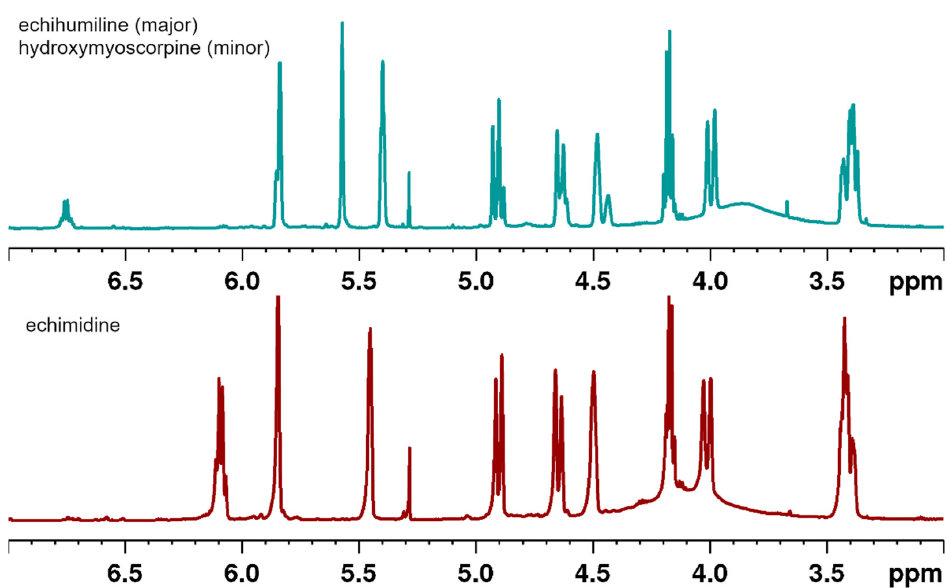
Figure 4. 1 H NMR spectra of echimidine and echihumiline-hydroxymyoscorpine mixture (CDCl 3 , 500 MHz).